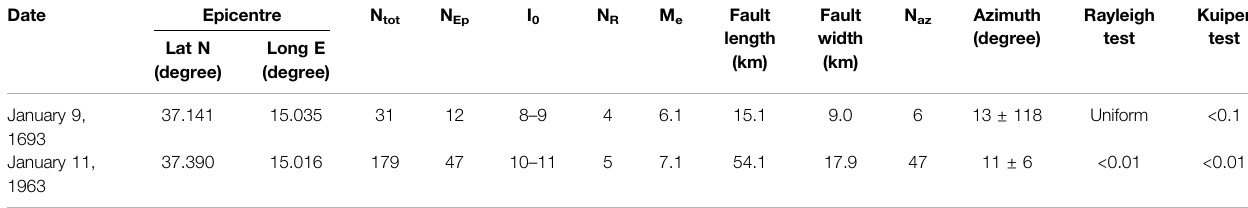
TABLE1| SourceparametersevaluatedusingintensitiesobtainedhereinbyBoxermodel(Gasperinietal.,1999).N tot isthetotalnumberofdataavailablefortheearthquake; N Ep is the number of intensity points used for computing the epicentre; I 0 is the epicentral intensity; N R is the number of data used to compute M e ; M e is the equivalent moment magnitude inferred using average radius (km) of different intensities; N Az is the number of intensity points used for computing the source azimuth with standard deviation; signi fi cance levels of the Rayleigh and Kuiper tests.